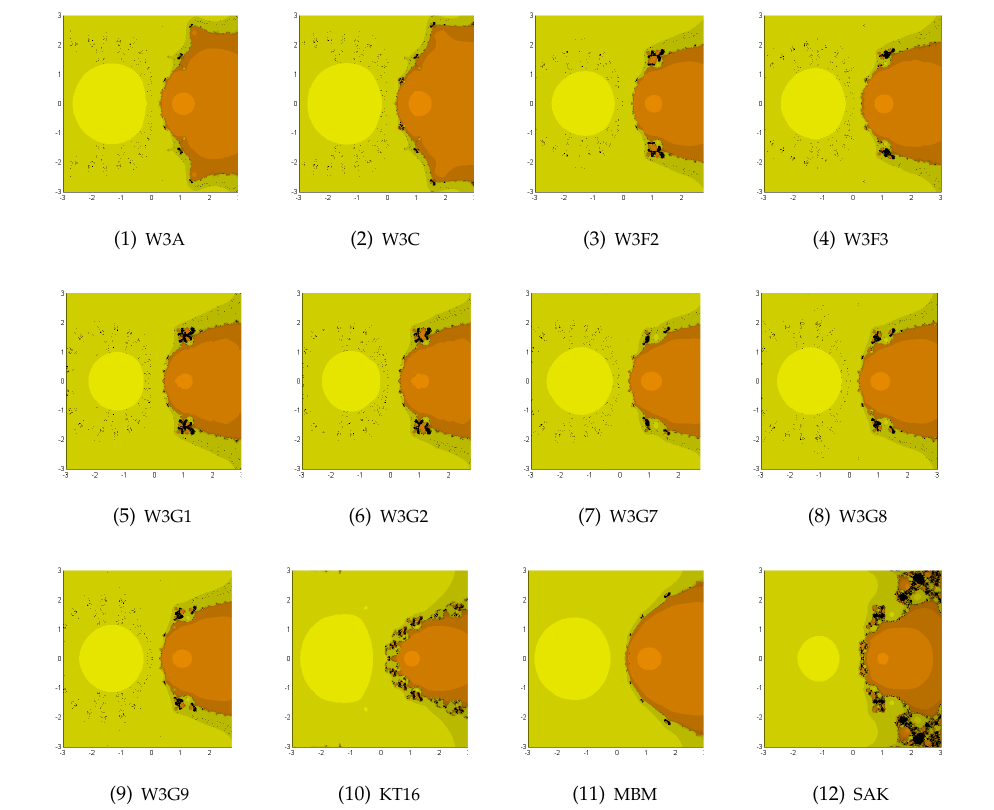
Figure 7. The top row for W3A (left), W3C (center left), W3F2 (center right), and W3F3 (right). The second row for W3G1 (left), W3G2 (center left), W3G7 (center right), and W3G8 (right). The bottom row for W3G9 (left), KT16 (center left), and MBM (center right) and SAK (right), for the roots of (cid:0) (cid:1) ( e z + 1 − 1 z − 1 ) non-polynomial equation